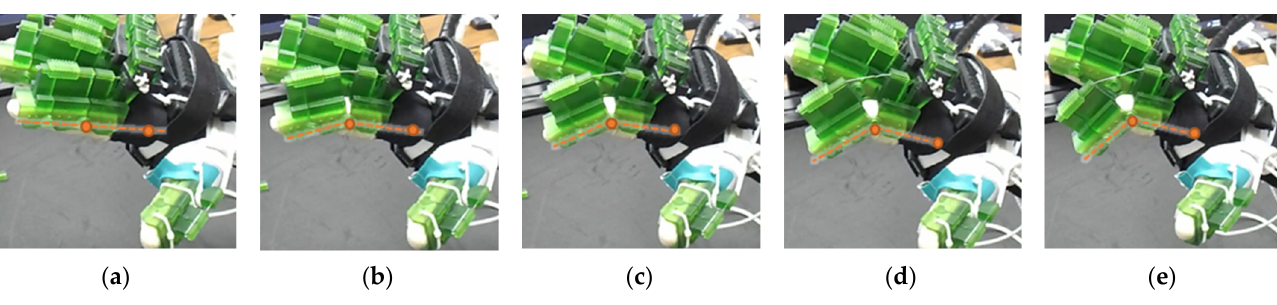
Figure 17. Isolated MCP extension of thumb: ( a ) thumb is at the flexed position, MCP joint angle: 25° ( b – d ) Intermediate MCP joint positions ( e ) thumb is at the extended position, MCP joint angle: 0°.